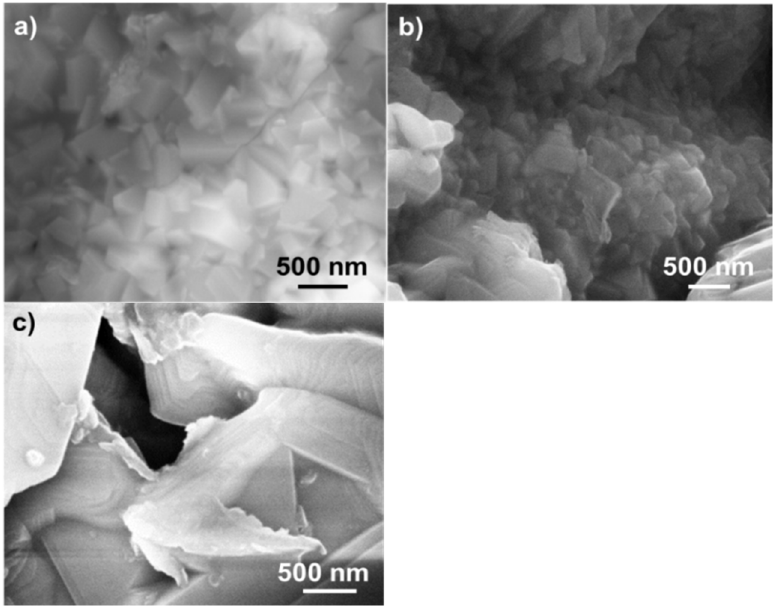
Figure 10. SEM morphology of ( a ) metal grains after removal of the oxide layer; ( b ) Al 2 O 3 grains grown at the boundary of metal particles; and ( c ) mixed oxide scales with polygonal (NiO) and equiaxed shape